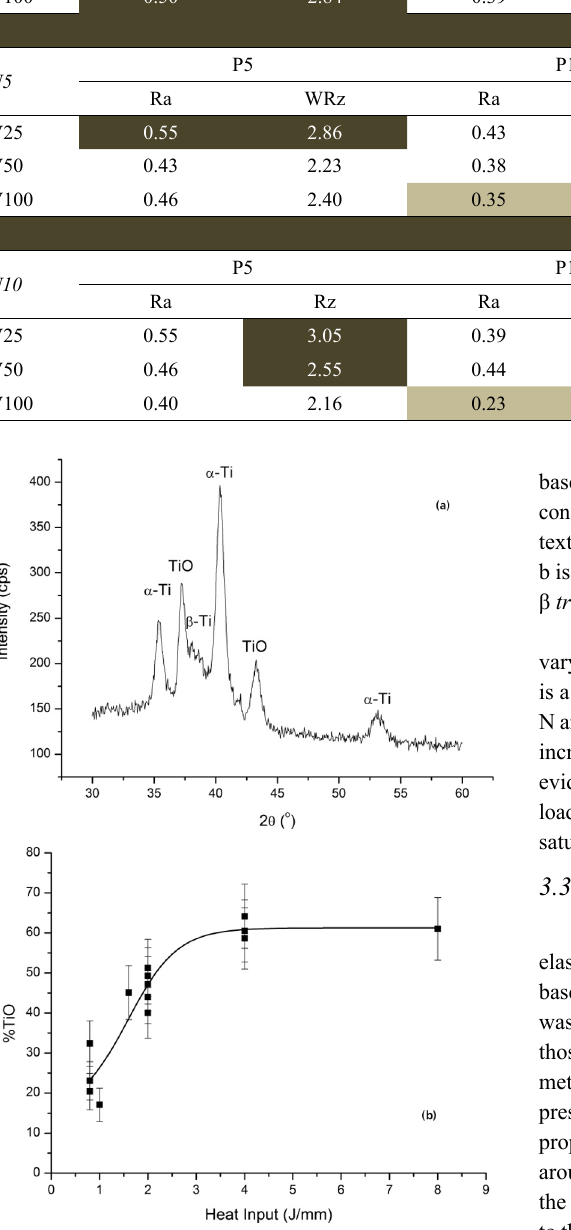
Figure 5. (a) X-ray diffraction spectrum of the sample in condition N10V50P10. (b) Influence of heat input in the amount of titanium oxide on the textured